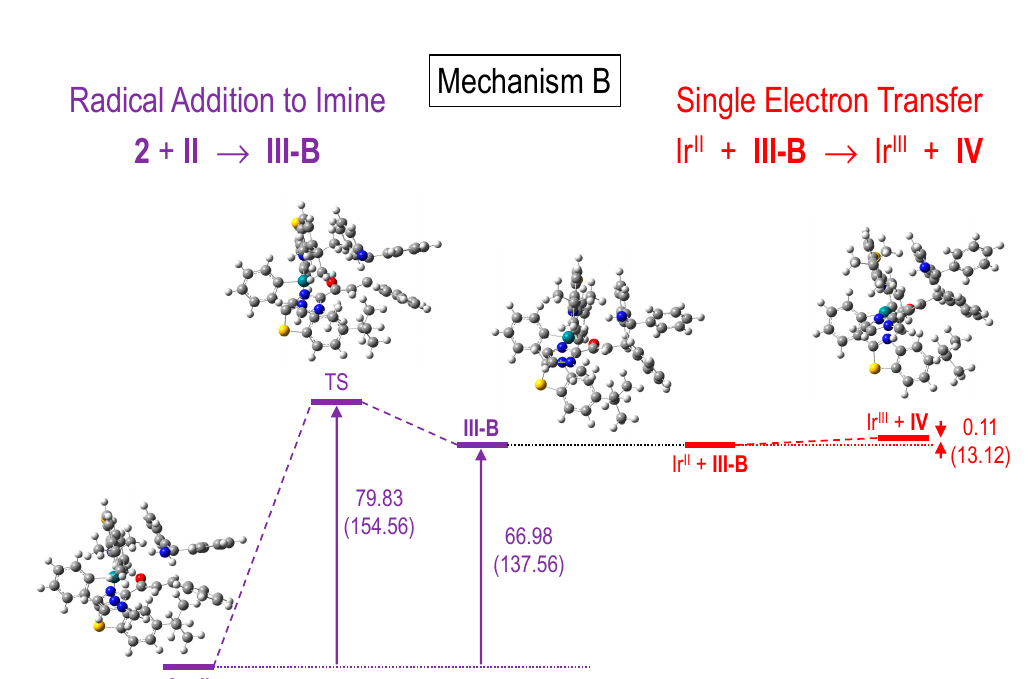
Figure 3. Relevant points in the potential energy of the two steps in mechanism B: radical addition to imine and single electron transfer in the reduction of III-B . Relative energies in kJ · mol − 1 are referred to the separated reactants and have been corrected with the zero-point energy E+ZPE.